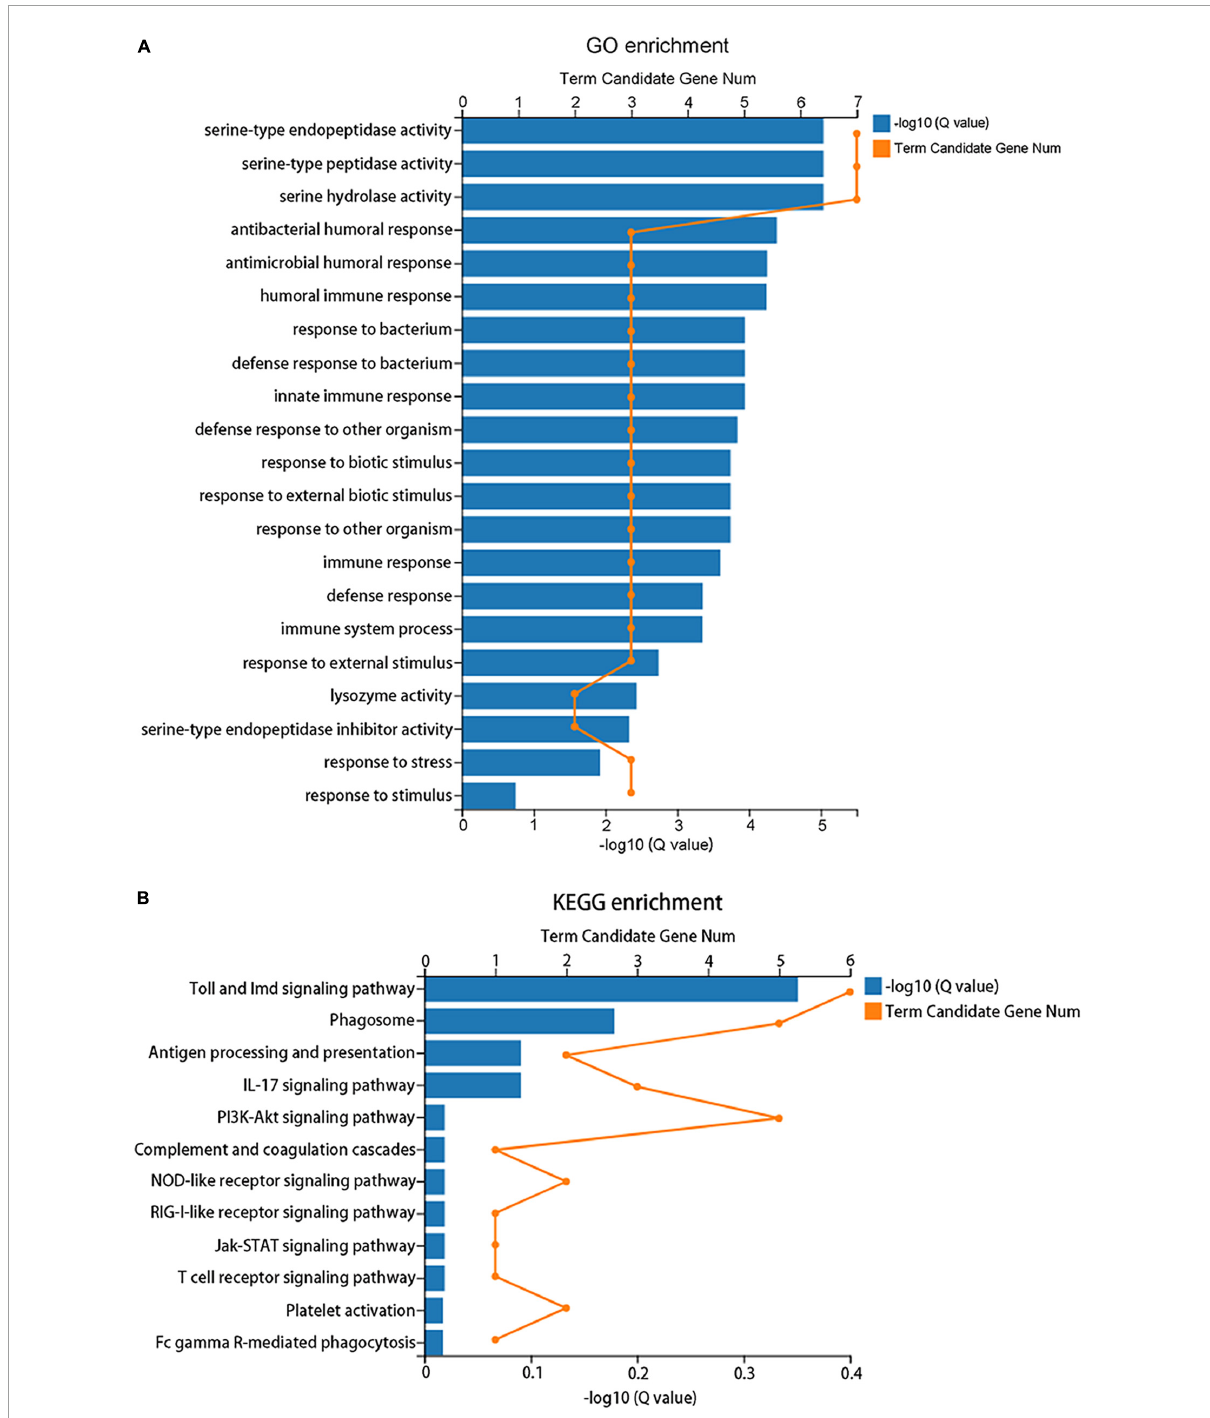
FIGURE8 Enrichment analysis of the differentially expressed genes. (A) GO enrichment indicates that 24 DEGs were enriched into 21 immune-related GO terms. (B) KEGG enrichment indicates that 25 DEGs were enriched into 12 immune signaling pathways.